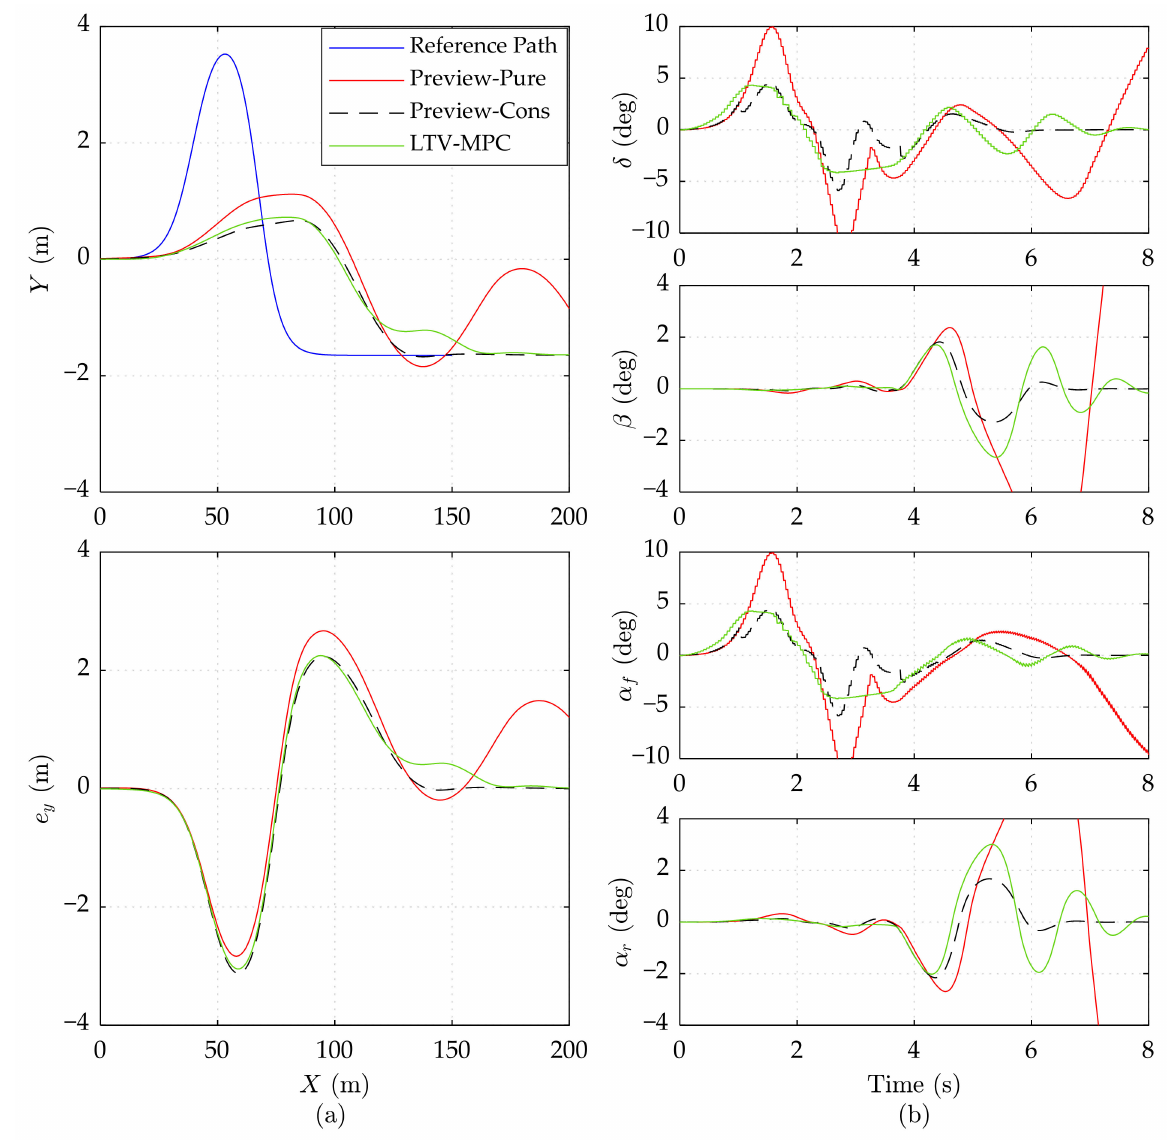
Figure 9. Simulation results of three controllers on the low adhesion road at 25 m/s speed. ( a ) Vehicle driving trajectory, lateral error e y . ( b ) Front wheel steering angle δ , mass center slip angle β , front wheel slip angle α f , and rear wheel slip angle α r . The results of Preview-Pure beyond range are cut